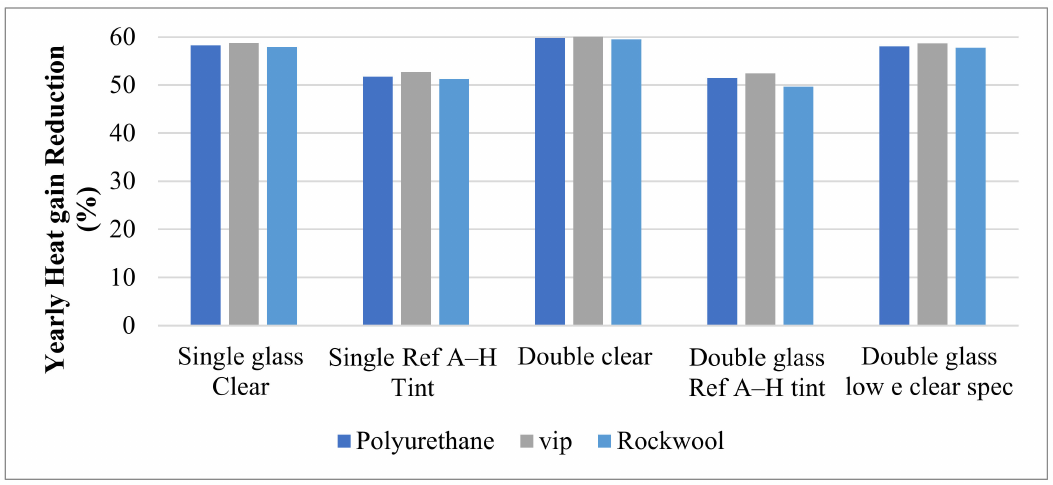
Figure 6. Yearly reduction in the total heat gain through different types of window glass applying three types of window shutters’